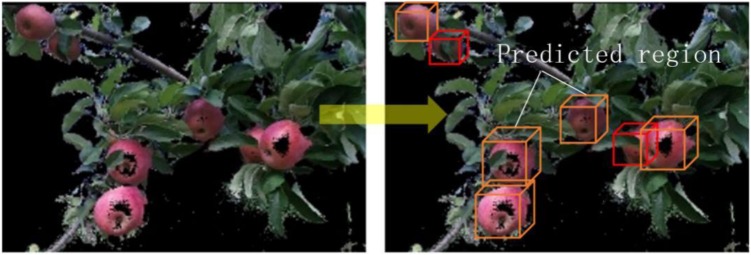
Apple identification implemented via RGB-D camera and SVM classifier (Tao and Zhou, 2017).